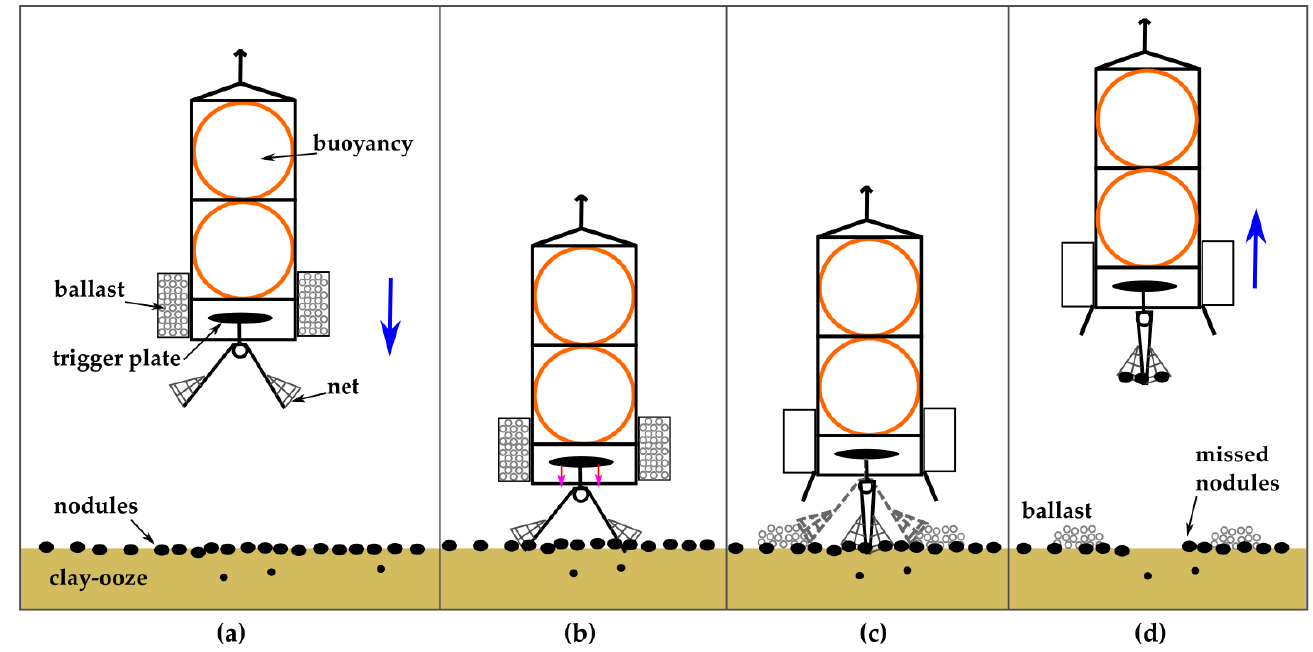
Figure 14. Schematic of the sampling process of nodules using free-fall grab (FFG). ( a ) Free-fall decent; ( b ) landing and trigger; ( c ) ballast dump and closing of grab with start of ascent; ( d ) free ascent. Modified from Lee et al. [60].